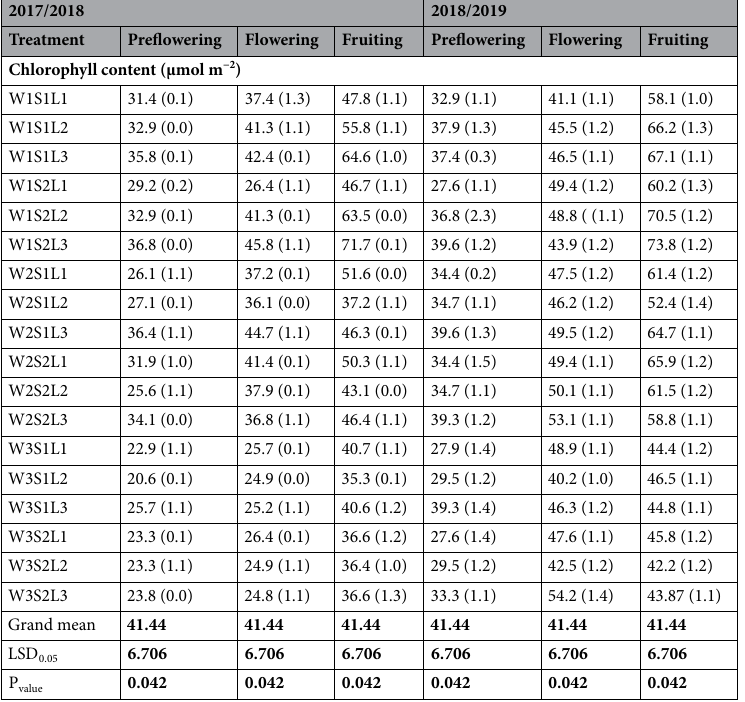
Table 1. Treatment interaction effect on the chlorophyll content (µmol m −2 ) of African horned cucumber. Treatment interaction effect on the chlorophyll content of African horned cucumber. W1 no water stress, W2 moderate water stress, W3 severe water stress, S1 loamy soil, S2 sandy loam, L1 greenhouse, L2 shade net, L3 open field. Numbers in brackets represent the standard deviations of the mean. LSD 0.05 is the least significant difference of means. Years (seasons one—2017/18 and season two—2018/2019). P values in bold are lower than